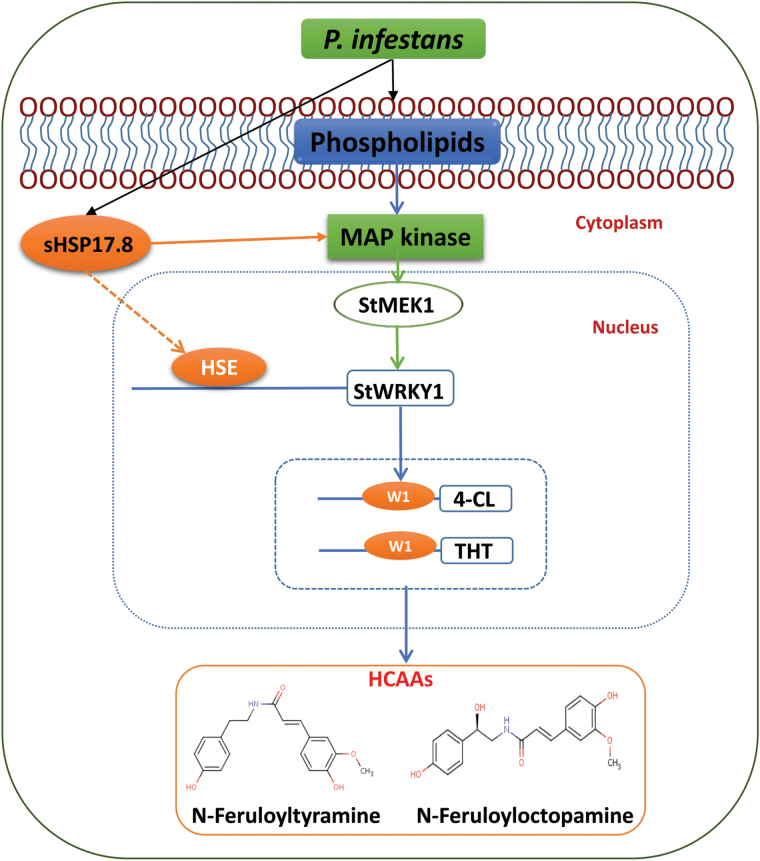
Proposed model of StWRKY1 in regulating secondary cell wall thickening. MEK1, MAPK1; see main text for further details.